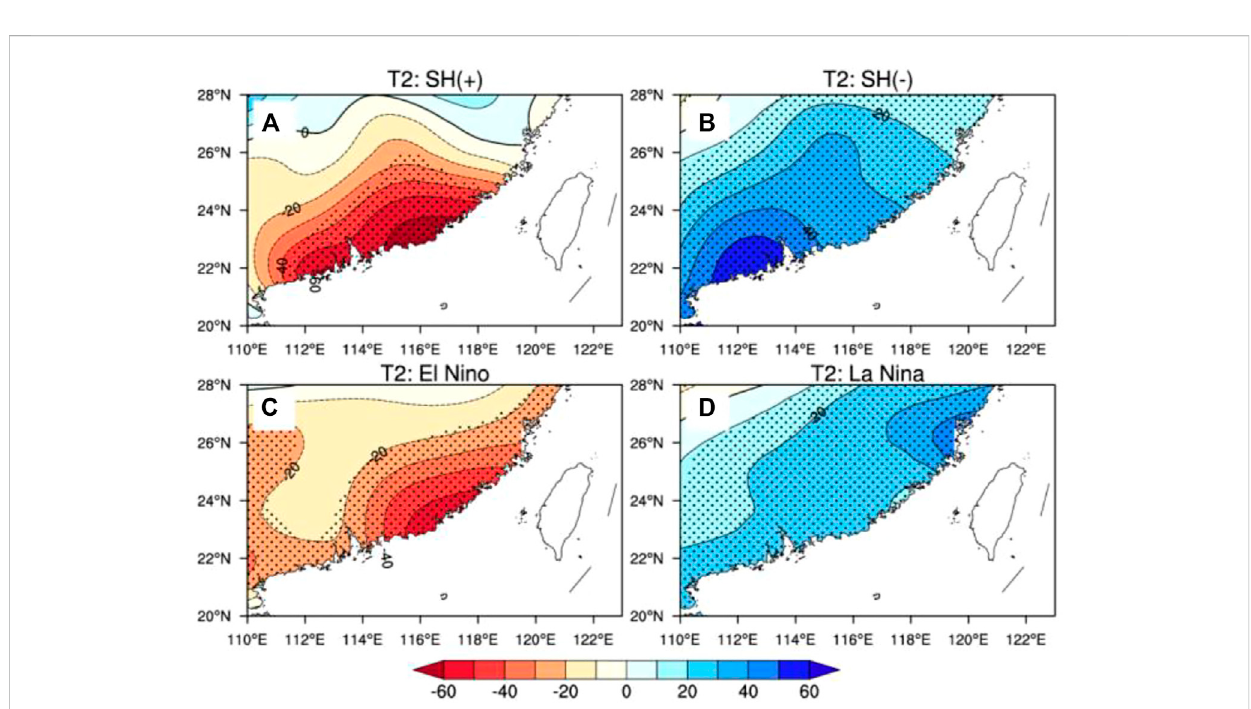
Composition of midsummer precipitation anomalies in South China in different phase years of the spring SH ( (A,B) represent years of positive and negative SH, respectively) and the Niño-3 index anomalies ( (C,D) represent years of El Niño and La Niña, respectively) under negative PDO phases during 1979 – 2019 (unit: mm; the dotted areas passing the 90% signi fi cance level